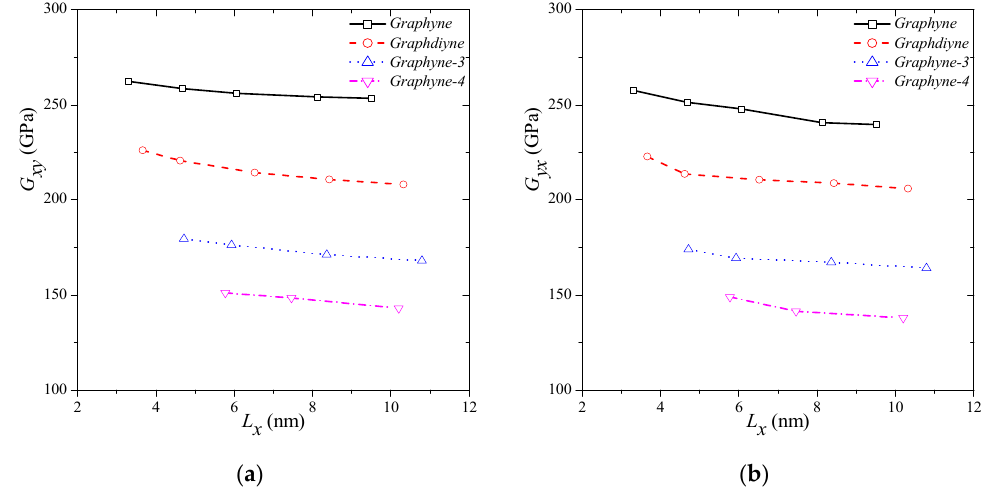
Figure 5. Shear modulus variations in different graphyne structures in ( a ) x–y and ( b ) y–x direction.